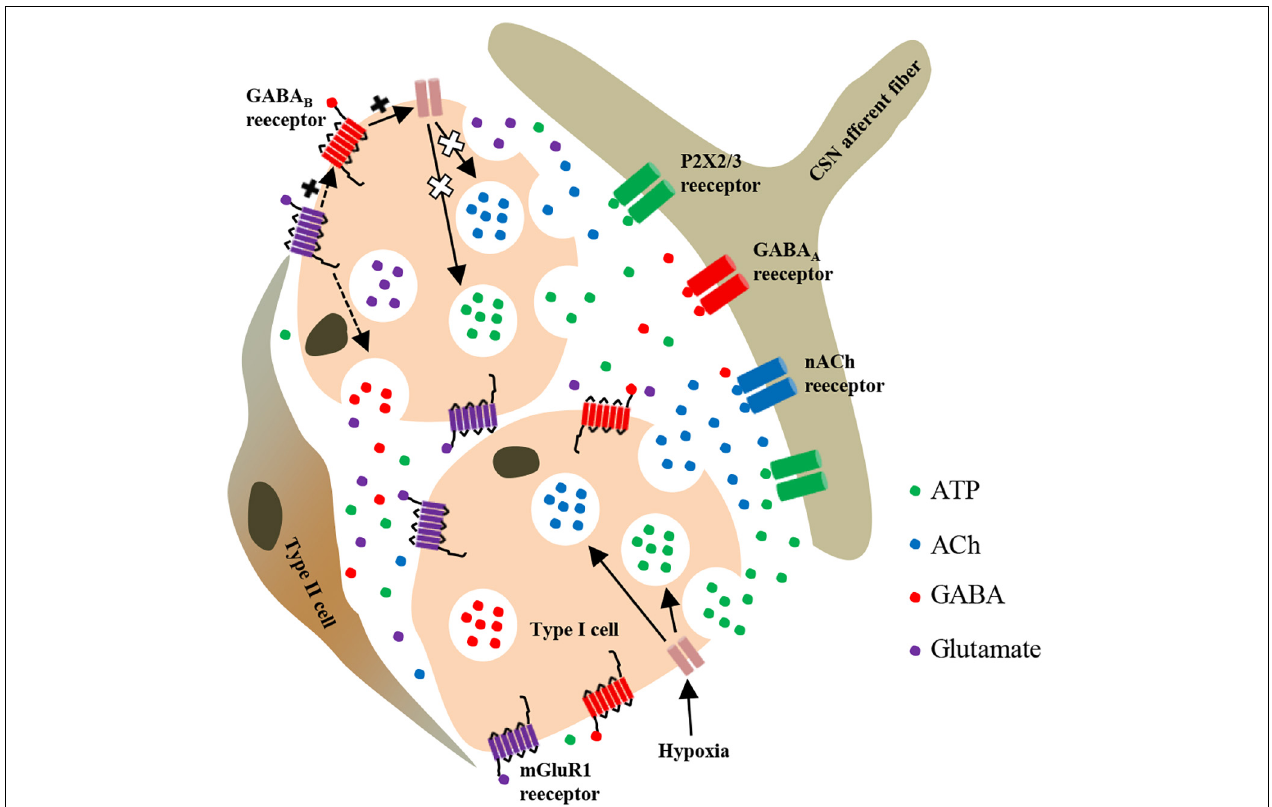
FIGURE 7 | Schematic representation of mGluR1-mediated regulation of neurotransmitter release from rat CB type I cells during hypoxia. Inhibition of TASK-1 in type I cells by hypoxia leads to membrane depolarization and release of various neurotransmitters. Among these neurotransmitters, glutamate and GABA act on presynaptic mGluR1 and GABA B receptors in themselves or in adjacent type I cells. GABA B activation further activates TASK-1, thus leading to an increase of potassium outflow, then limiting the degree of depolarization of type I cells in order to inhibit the further release of ATP and ACh induced by hypoxia. Additionally, mGluR1 activation may enhance the activation effect of GABA B receptor on TASK-1 through synergistic enhancement or modulate the release of GABA. In other words, both mGluR1 and GABA B receptors on type I cells regulate the CSN afferent signals of CB response to hypoxia through a presynaptic feedback mechanism. P2X2/3, purinergic P2X2/3 receptor; nACh, nicotinic ACh